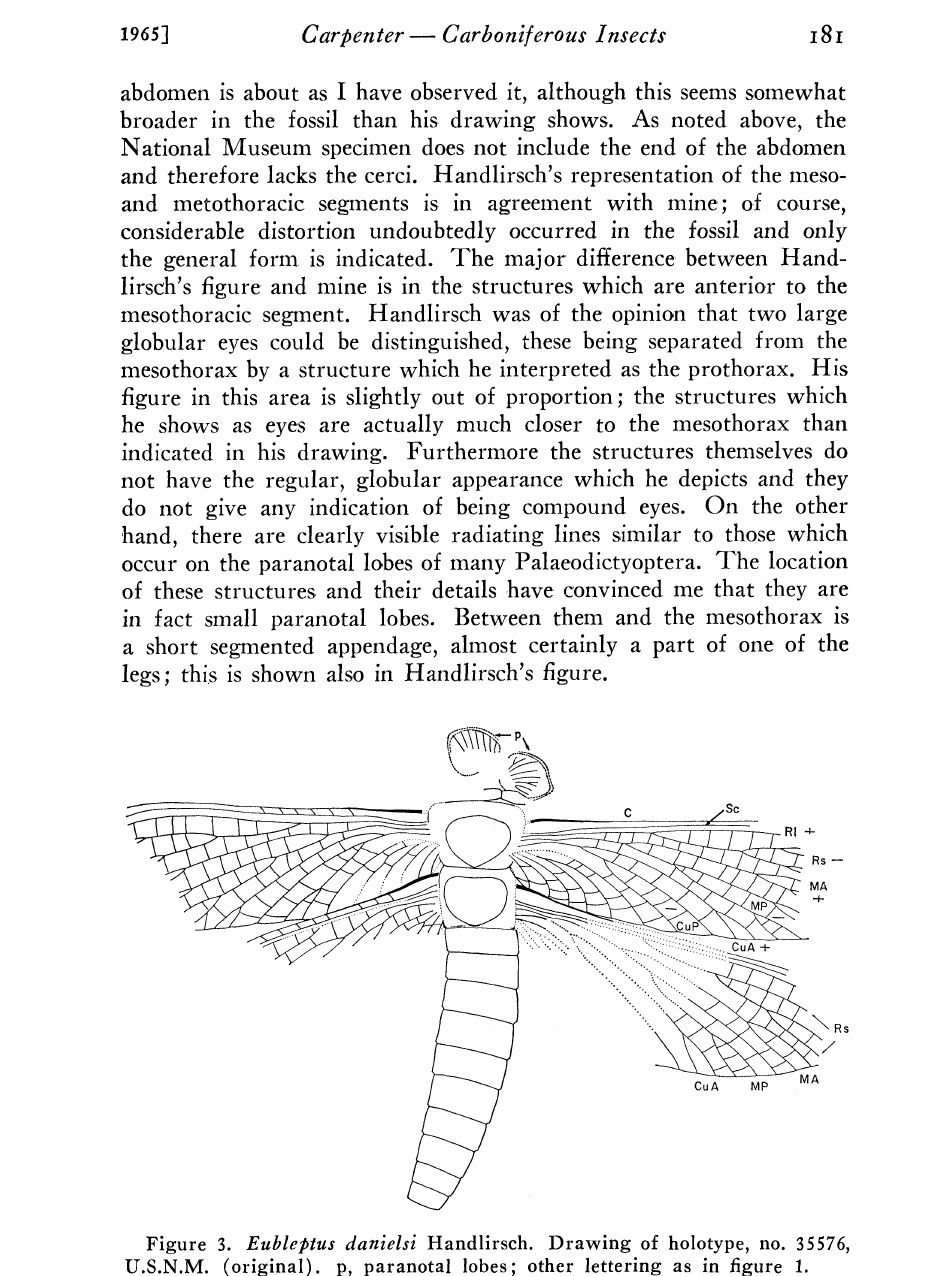
Figure 3. EubleItus danielsi Handlirsch. Drawing of holotype, no. 35576, U.S.N.M. (original). p, paranotal lobes; other lettering as in figure